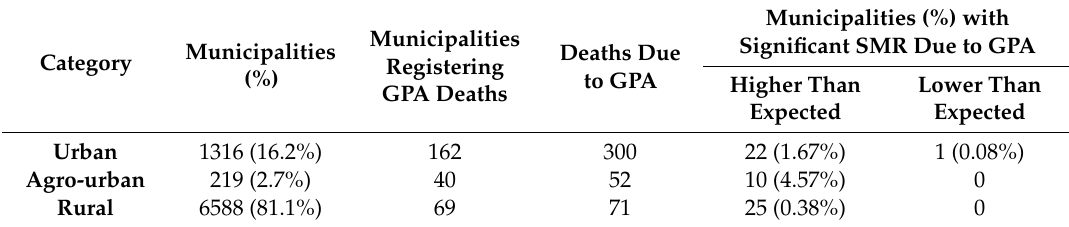
Table 1. Distribution of municipalities categorized as urban, agro-urban or rural; number of deaths due to GPA and municipalities with higher or lower GPA mortality than expected for Spain in 1999– 2016 (only statistically significant differences are shown, p < 0.05).